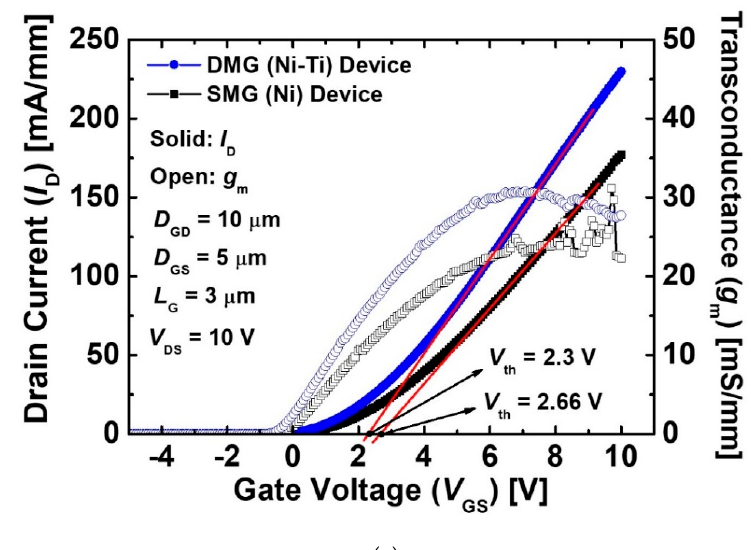
Figure 1. Schematic cross-sections of the recessed-gate GaN metal–oxide–semiconductor field-effect transistor (MOSFET) with ( a ) the single-metal-gate (SMG) and ( b ) dual-metal-gate (DMG) structures. ( c ) Optical microscope image of the fabricated DMG-based